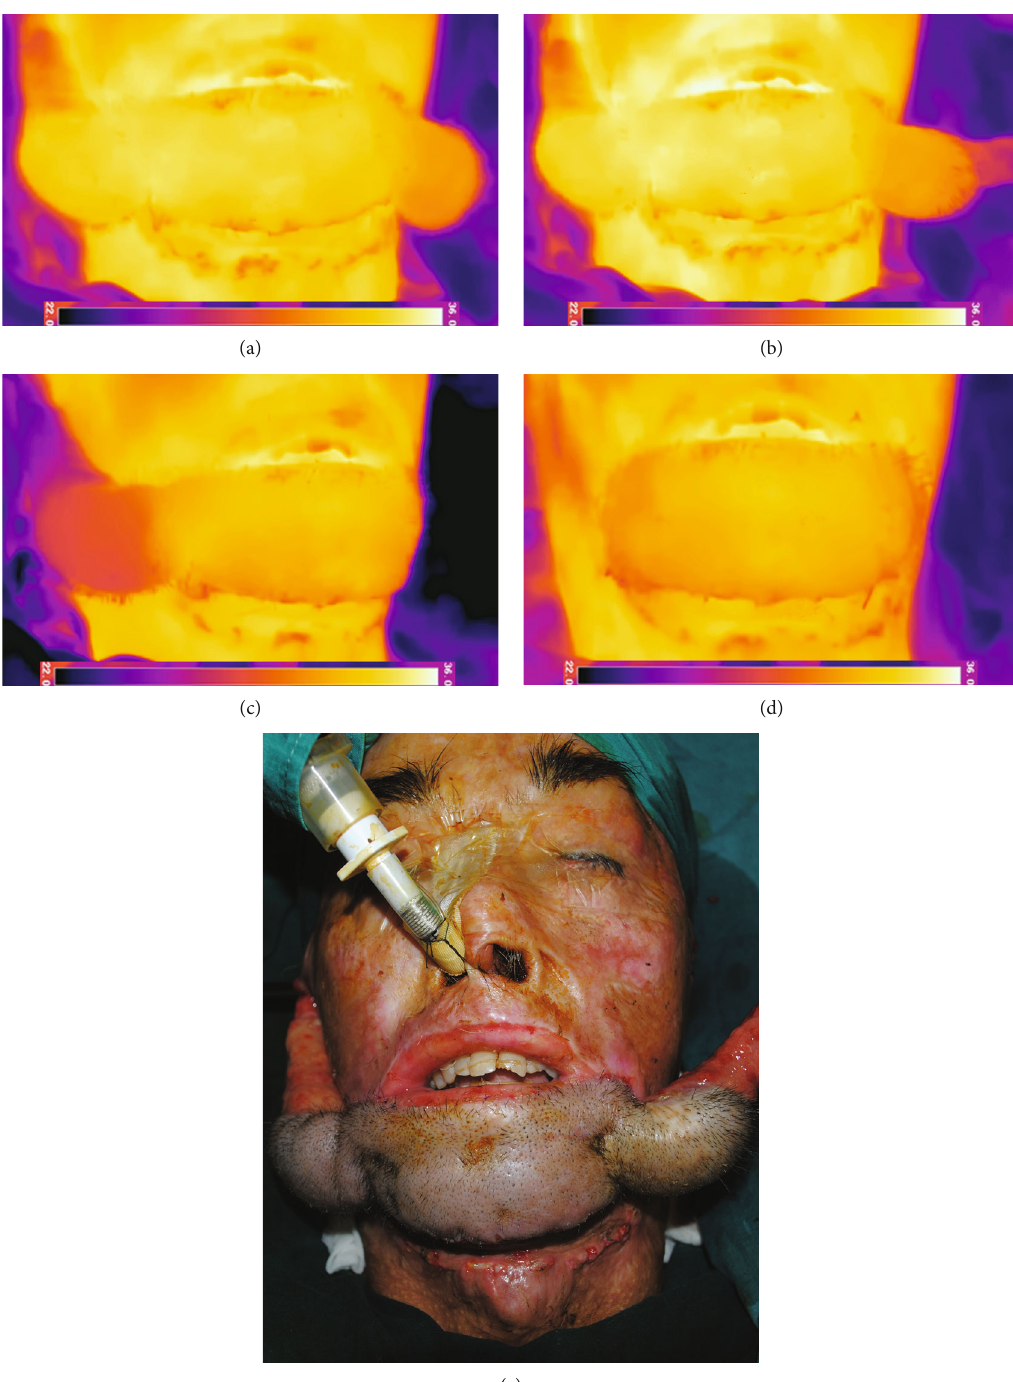
Figure 2: Monitoring of the temperature change during each stage of the operation (temperature threshold: 22-36 ° C). (a) The baseline temperature after stabilized anesthesia. (b) The temperature after the division of the left pedicle. (c) The temperature after clamping the right pedicle. (d) The temperature after both divisions. (e) The intraoperative fl ap appearance (the left pedicle was detached). Note that no obvious di ff erence between the postclamping and the postdivision temperature of the fl